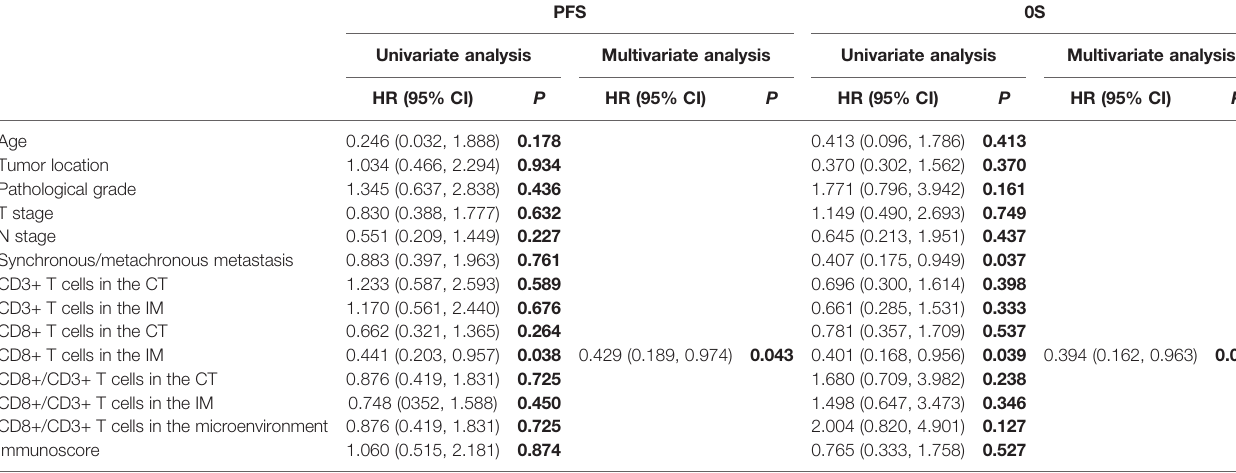
TABLE 7 | Univariate and multivariate analyses of immune cell in fi ltration and clinicopathological factors on survival for patients on bevacizumab plus chemotherapy.